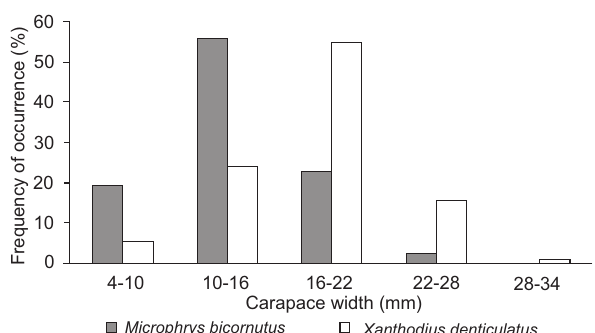
Figure 7. Carapace size distribution of the two main prey species ( Xanthodius denticulatus and Microphrys bicornutus ) identified in the food remains of Octopus insularis dens, at Atol das